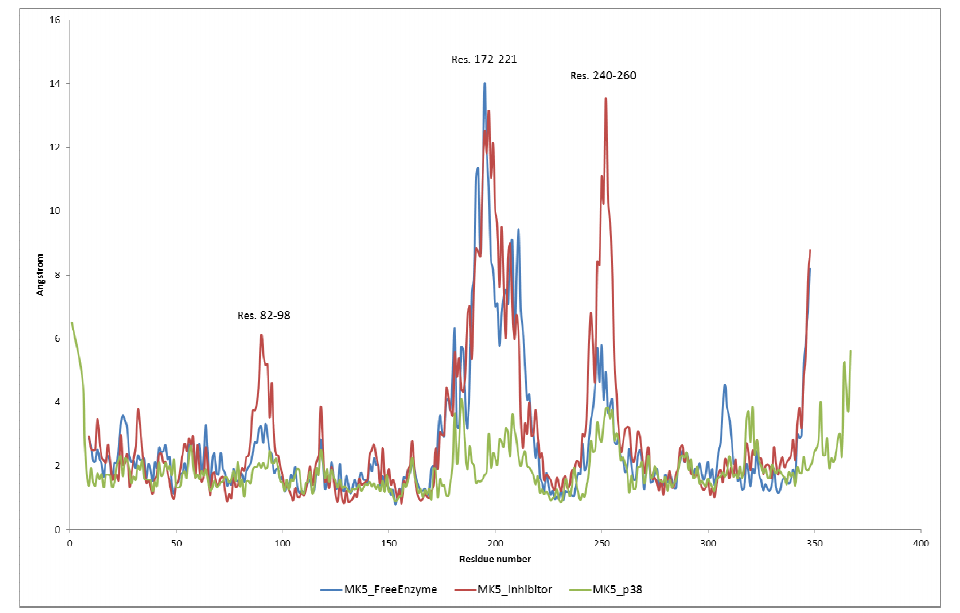
Figure 5. The Root Mean Square Fluctuation (RMSF) during 100 ns MD. All atoms were included in the RMSF